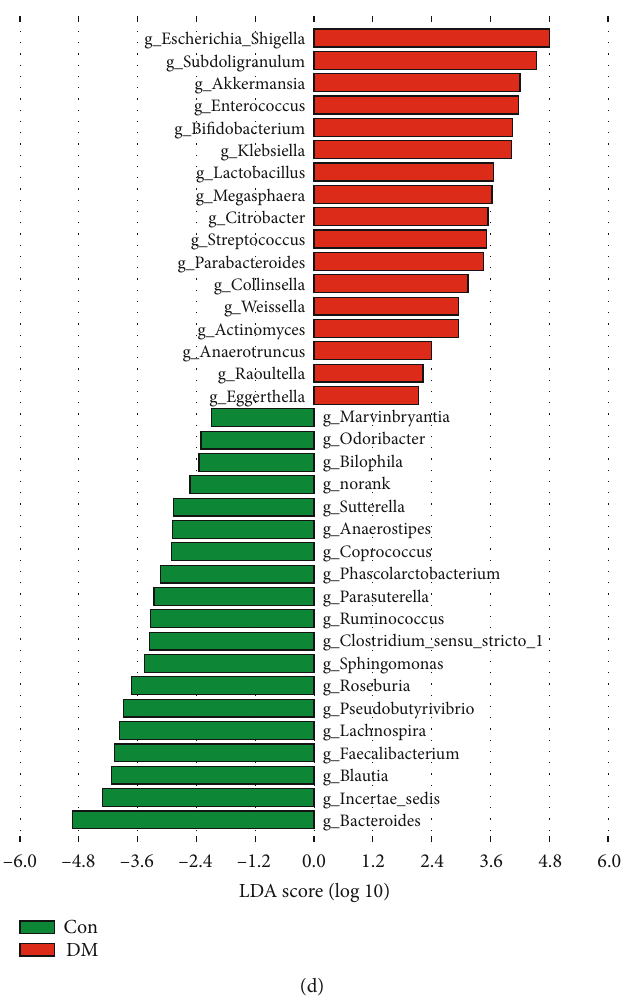
Figure 2: Composition of the gut microbiome in the DM or Con group. (a, b) Distribution of di ff erential fl ora at the phylum and genus levels between the DM and Con groups. (c, d) LEfSe analysis of microbial pro fi les between DM and Con at the phylum and genus levels. MN, DM: diabetes mellitus; Con: control group; OTUs: operational taxonomic units; LDA and LEfSe: linear discriminate analysis and e ff ect